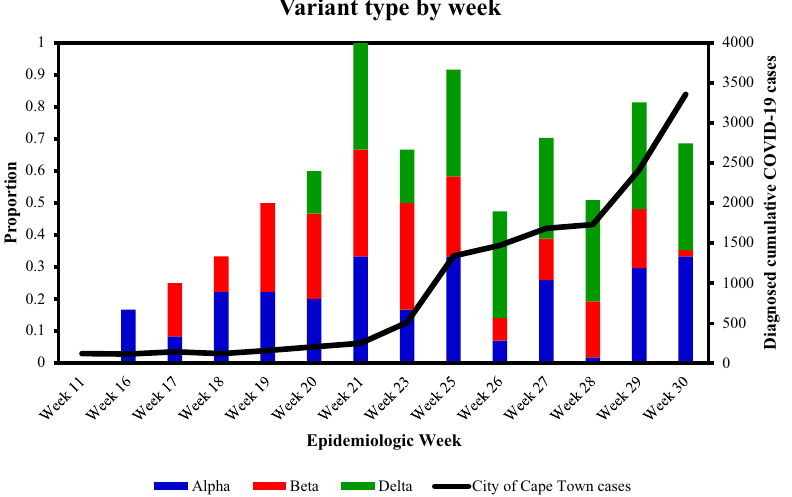
Figure 3. Temporal analysis of SARS-CoV-2 variants of concern compared to diagnosed COVID-19 cases. Data suggests that the Beta variant predominance decreases with dominance of Delta variant. Data is represented as a stacked bar graph. Each colour represents the average frequency of a variant type that occurs across all WWTPs, and the proportion of that specific variant compared to other variants is given by